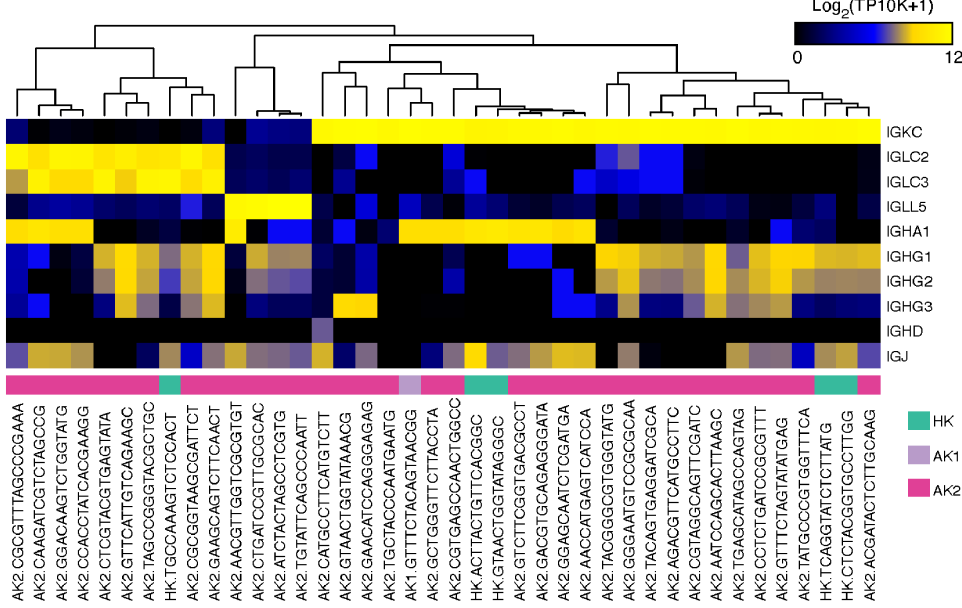
Fig 15. Immunoglobulin gene expression in plasmablast cells. Heatmap depicts the expression of immunoglobulin gene constant regions in plasmablast cells in HK, AK1, and AK2 samples. The X axis shows barcodes of individual plasmablast